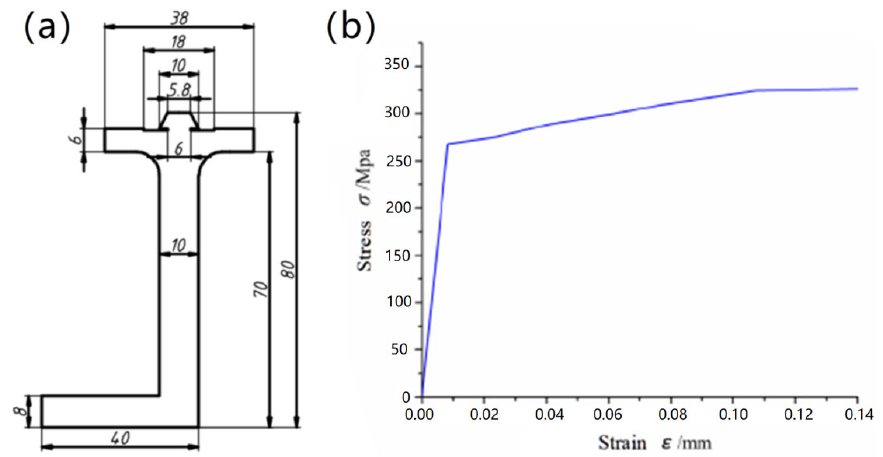
Figure 3. ( a ) The cross-section shape of profile, ( b ) stress–strain curve of aluminum profile. Table 1. Material parameters.